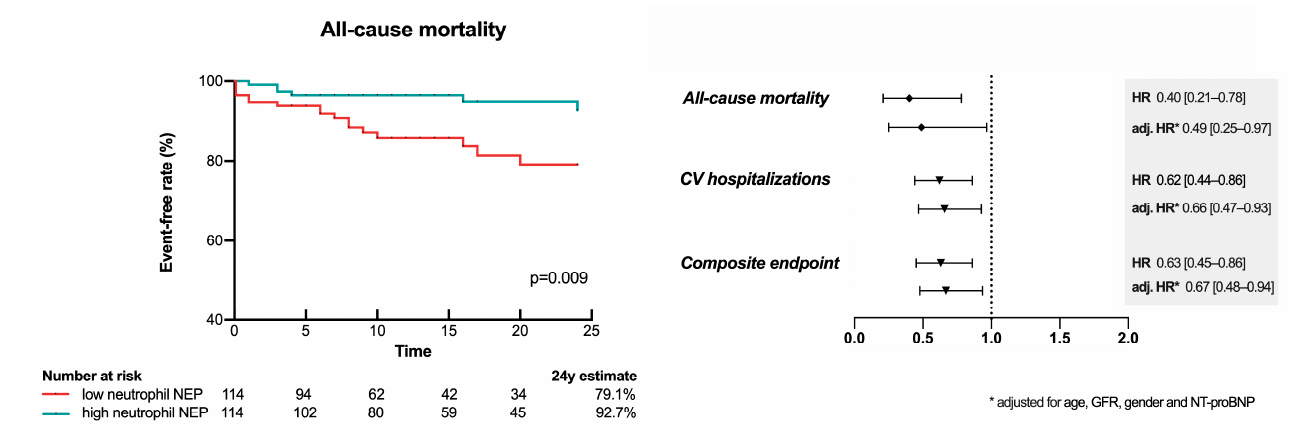
Figure 3. Neutrophil membrane-associated neprilysin (mNEP) expression and outcome. Unadjusted and adjusted effects of neutrophil mNEP expression on all-cause mortality, total cardiovascular (CV) hospitalizations, and the composite endpoint of both in HFrEF patients. Hazard ratios (HR) refer to a 1-interquartile range (IQR) increase in continuous variables. Hazard ratios (HR) are adjusted (adj.) for influencing variables, i.e., age, glomerular filtration rate (GFR), sex, and N-terminal pro-brain natriuretic peptide (NT-proBNP). Kaplan–Meier analysis for the primary outcome all-cause mortality with low and high neutrophil mNEP expression with the median MFI as the cut-off value. Comparison was calculated by the log-rank test.